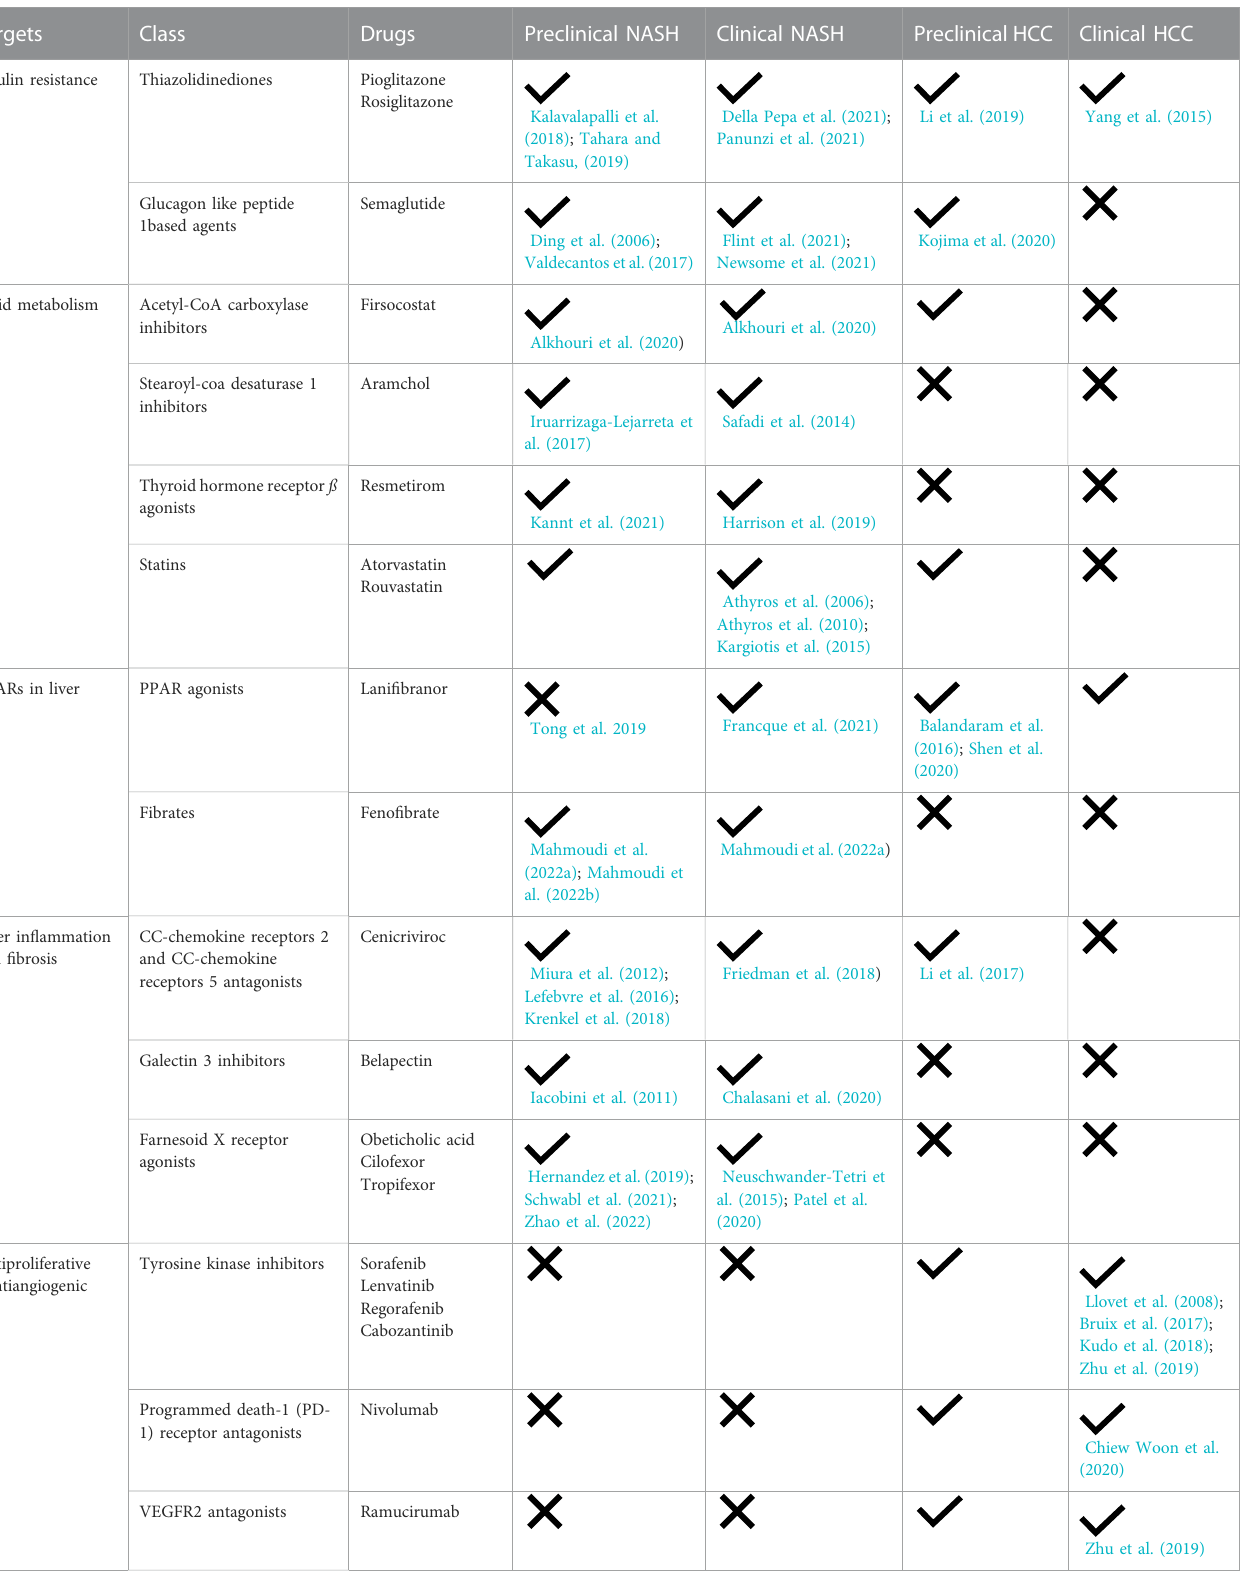
TABLE 1 Therapeutic interventions for NASH and